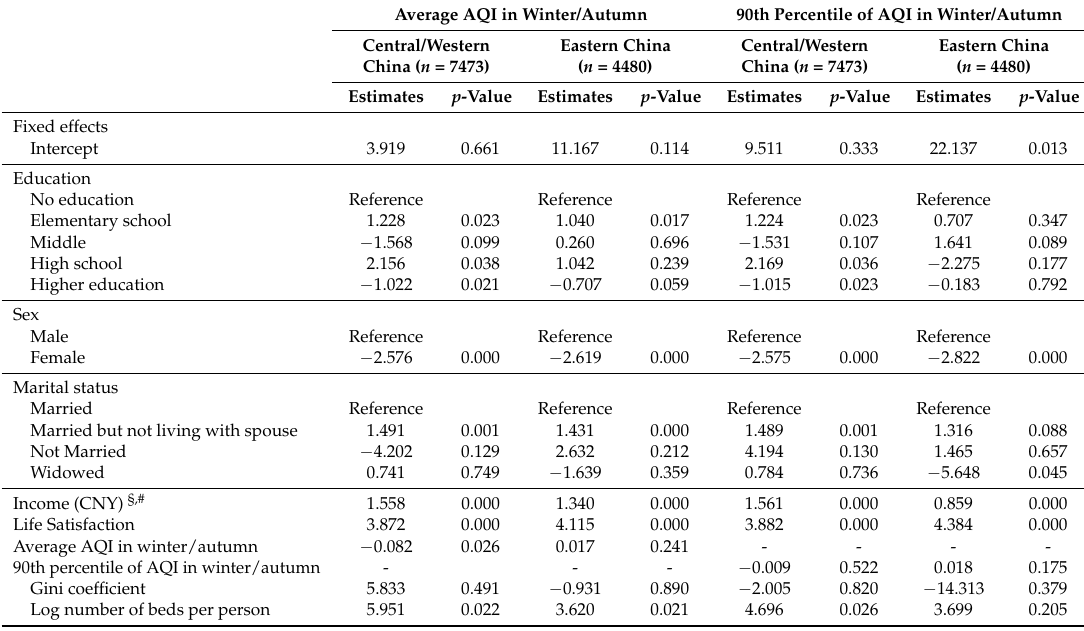
Table 4. Multilevel models of health score and average/90th percentile of Air Quality Index in